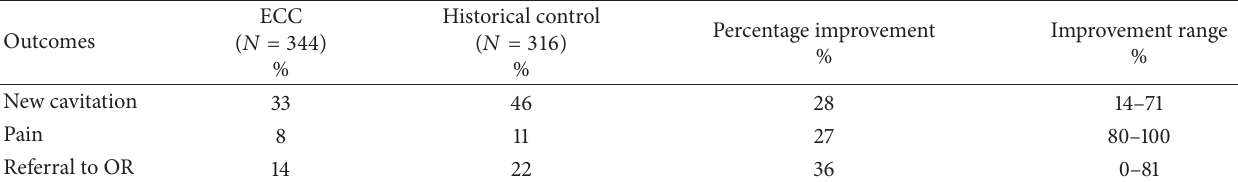
Table 3: ECC Phase 2: comparison of rates of new cavitation, pain, and referral to OR between ECC patients and historical